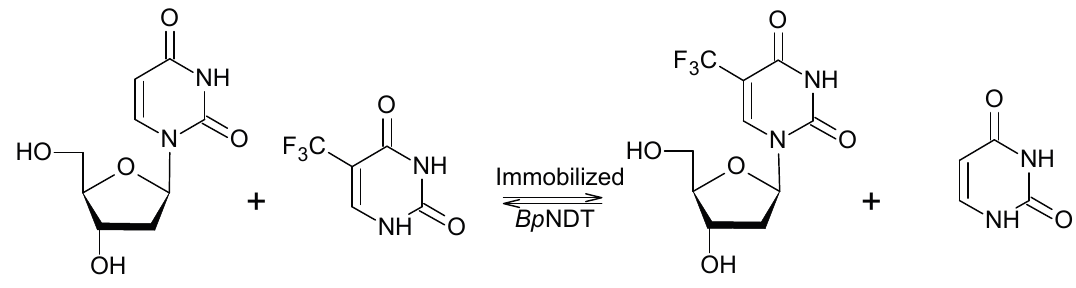
Figure 5. Synthesis of 5-trifluorothymidine (trifluridine) from 2'-deoxyuridine and